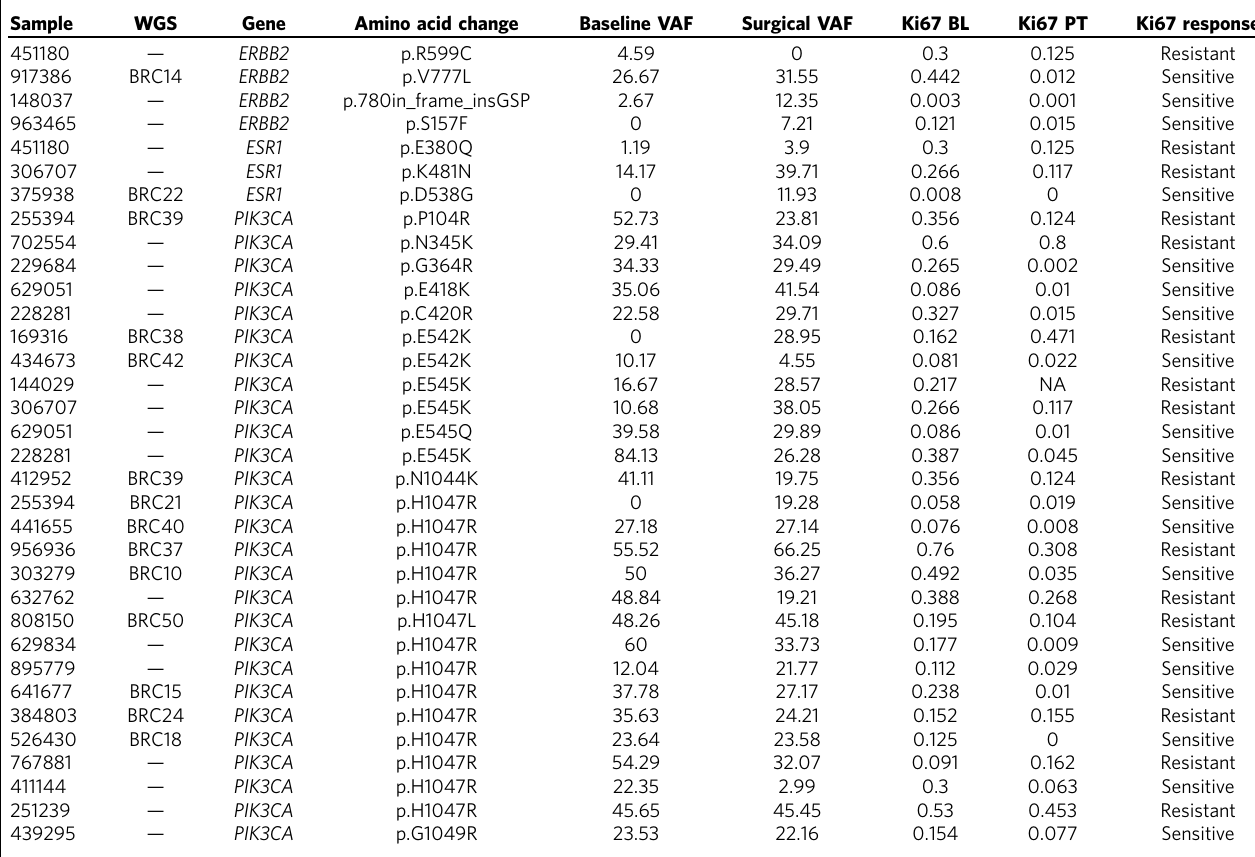
Table 3 | Druggable mutations observed in samples assayed with targeted sequencing.